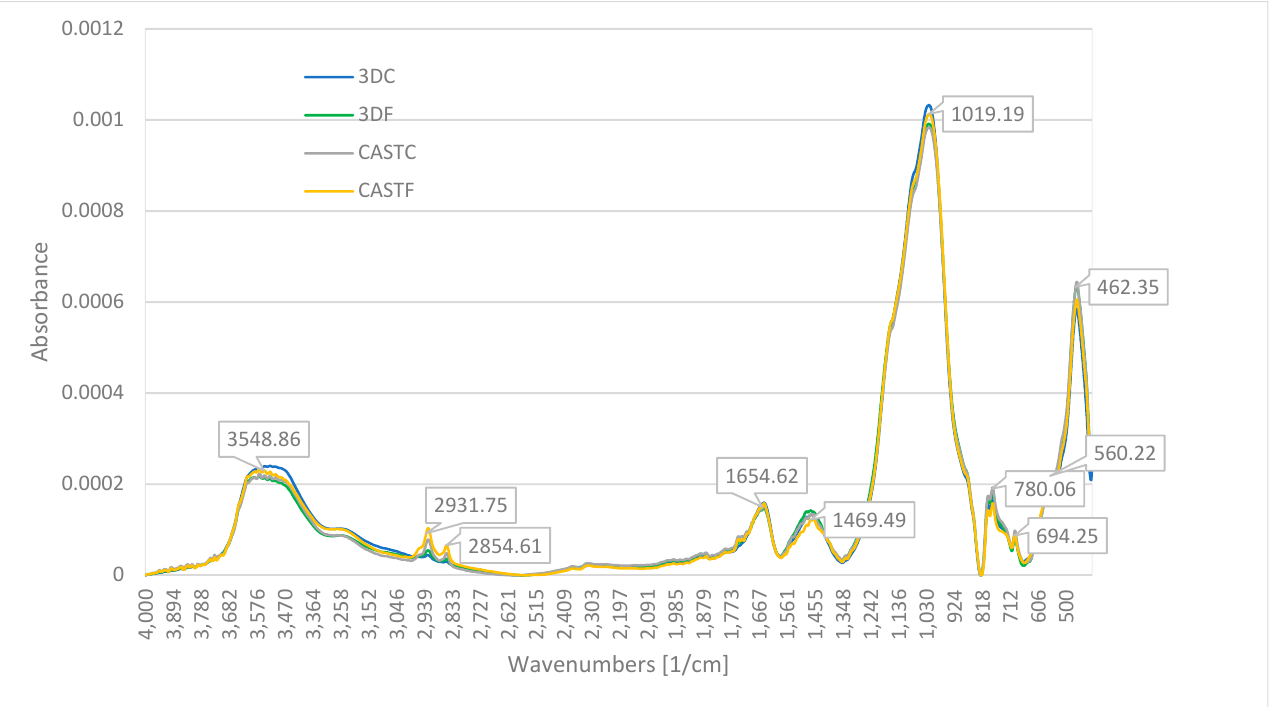
Figure 2. FT-IR for geopolymer composites.